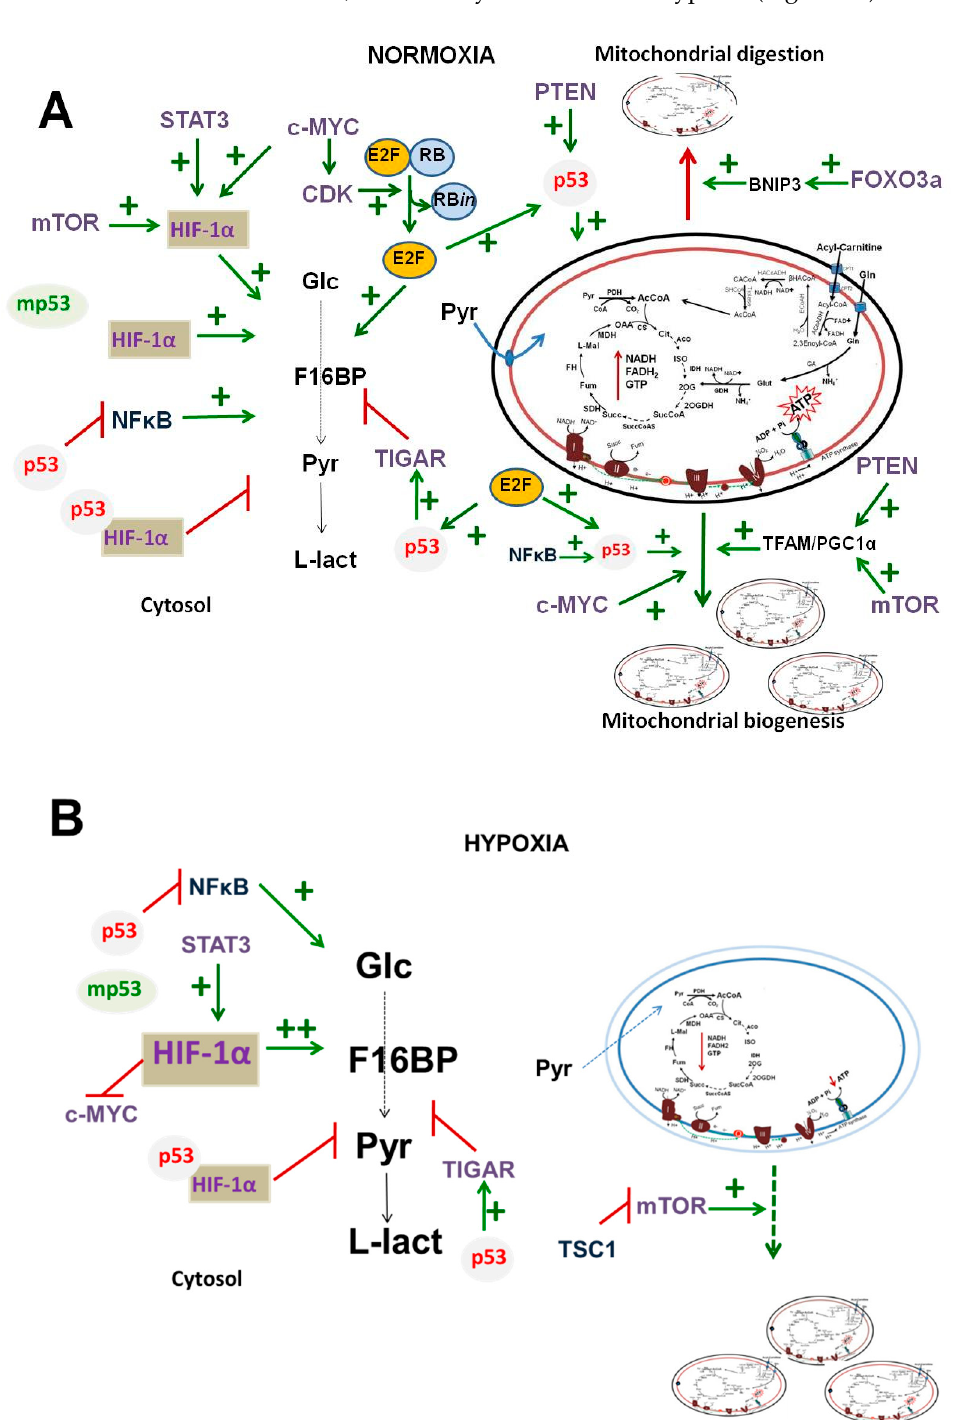
Figure 3. Transcription regulator interplay, acting on energy metabolism under ( A ) normoxia and ( B ) hypoxia. Abbreviations as in Figures 1 and 2; mp53, mutant p53; RB in , inactive RB protein.